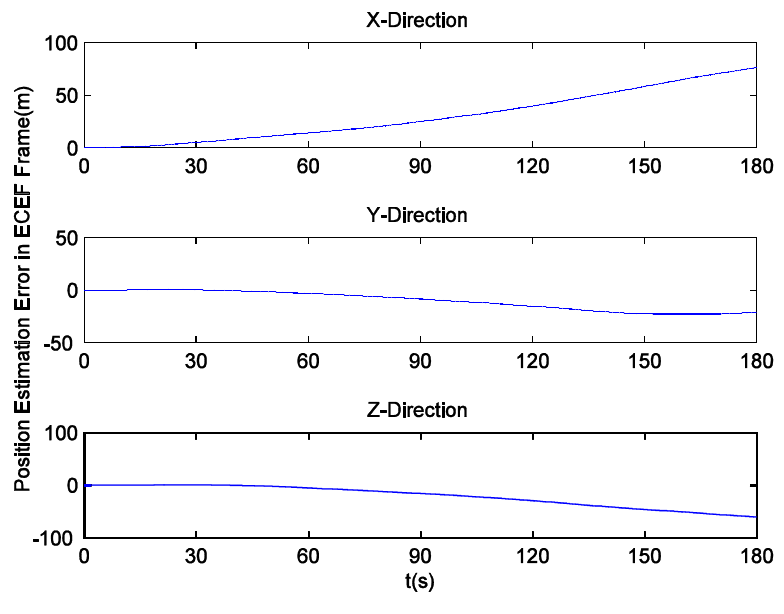
Figure 16. INS position estimation errors.